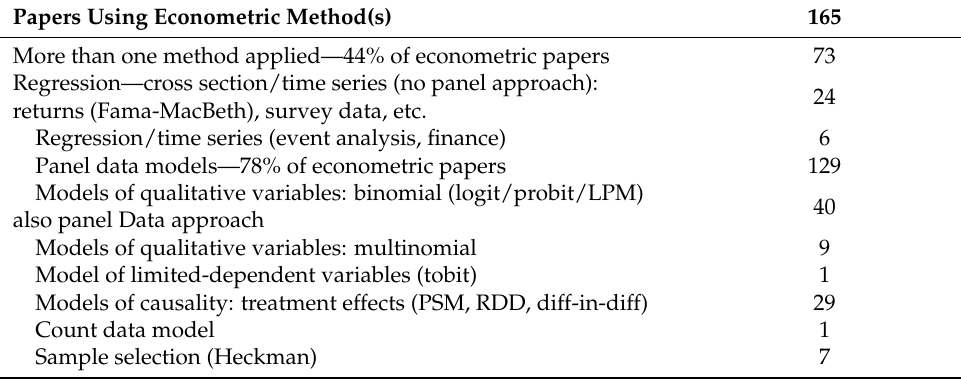
Table 4. Numbers of papers using specific econometric methods. Papers Using Econometric Method(s) More than one method applied—44% of econometric papers Regression—cross section/time series (no panel approach): returns (Fama-MacBeth), survey data, etc. Regression/time series (event analysis, finance)